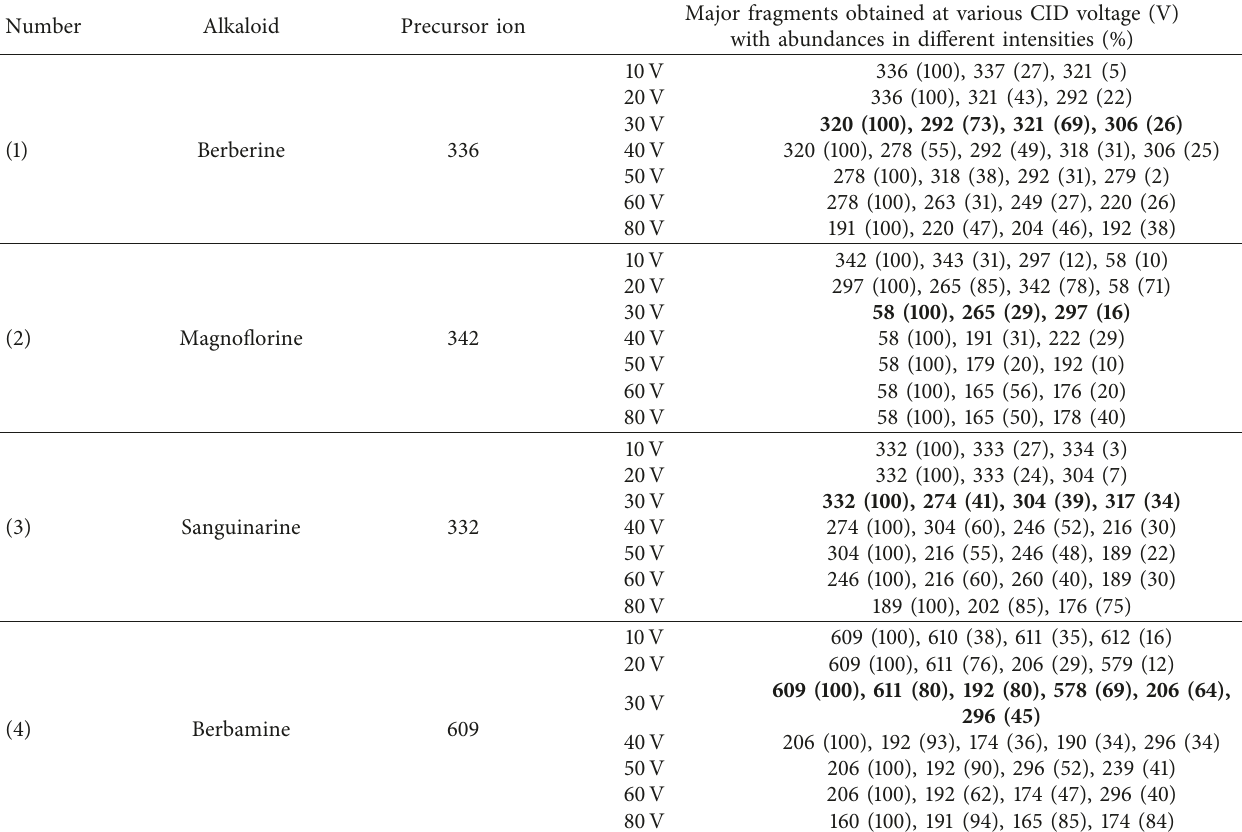
Table 4: The behaviour of model alkaloids in different collision energies together with the abundance of obtained signals. Major fragments obtained at various CID voltage (V) Number Alkaloid Precursor ion with abundances in different intensities